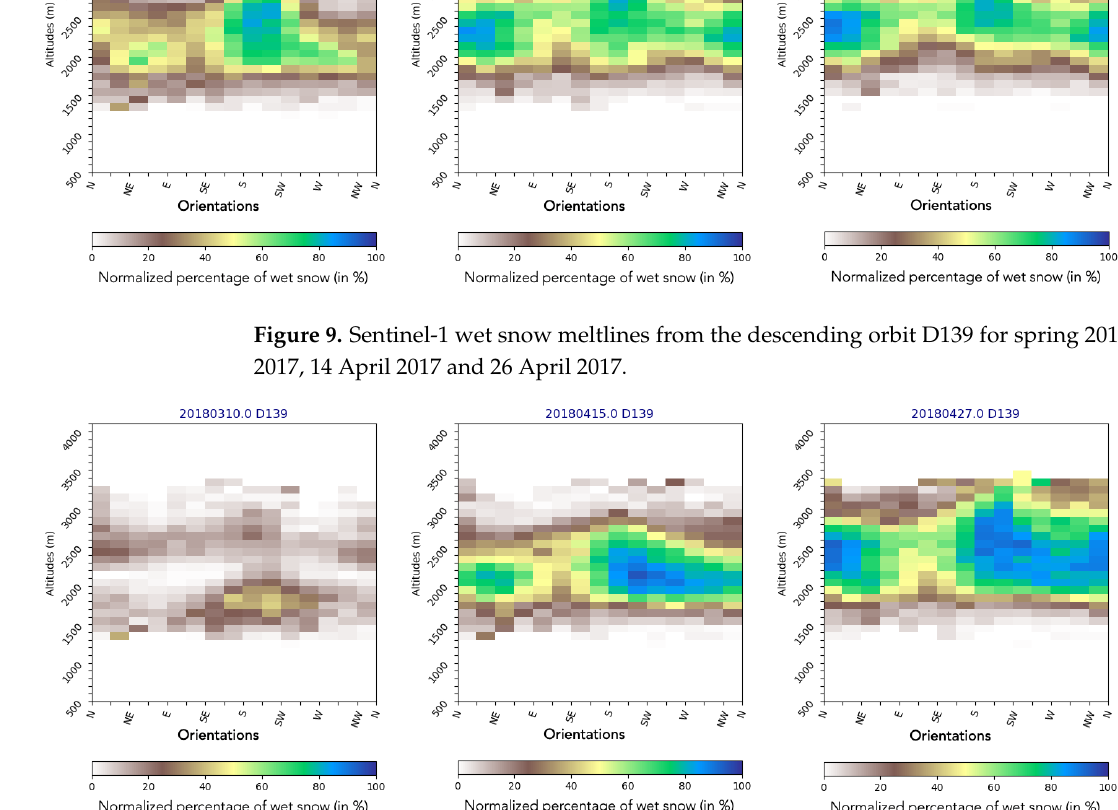
Figure 10. Same as Figure 9 but for spring 2018: 15 April 2018, 21 April 2018 and 27 April